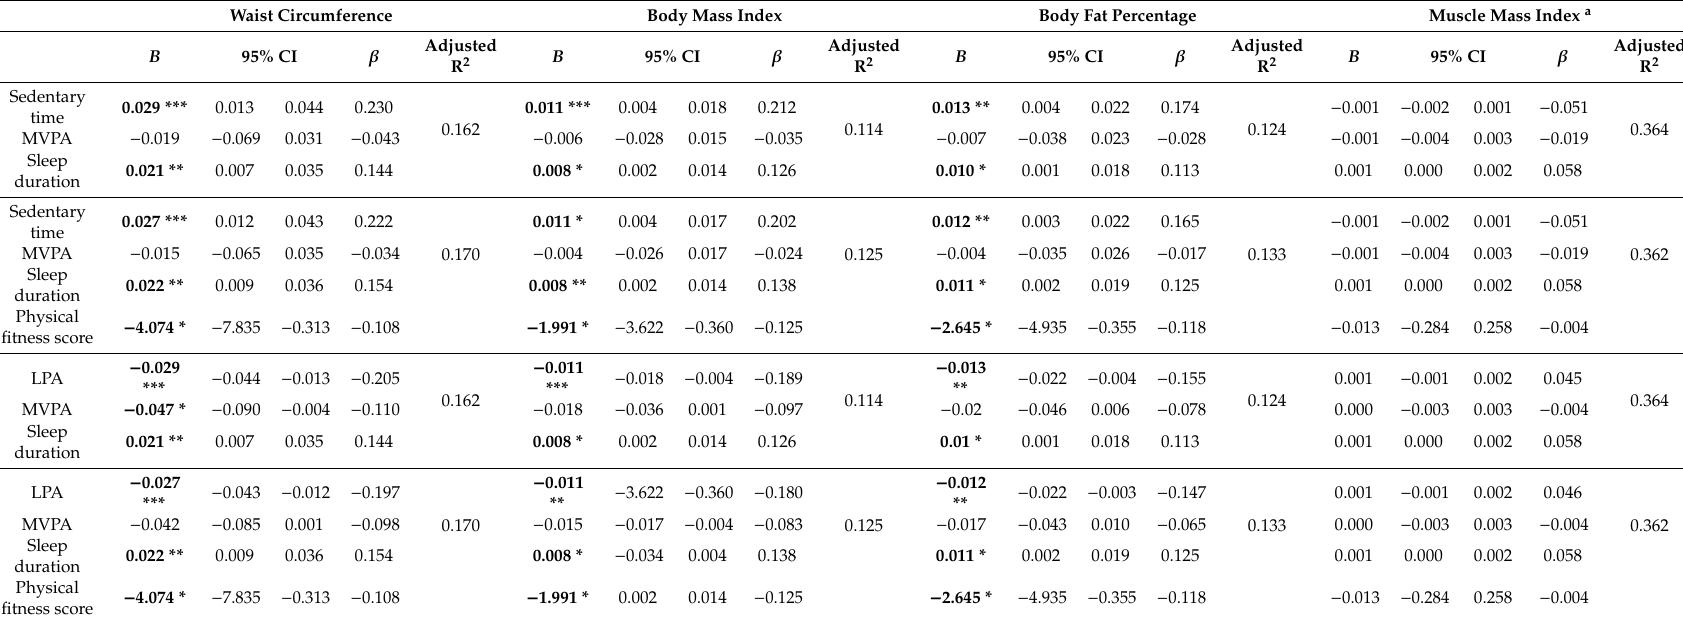
Table 3. Independent association of sedentary time, physical activity intensity, sleep duration, and physical fitness with body composition. Waist